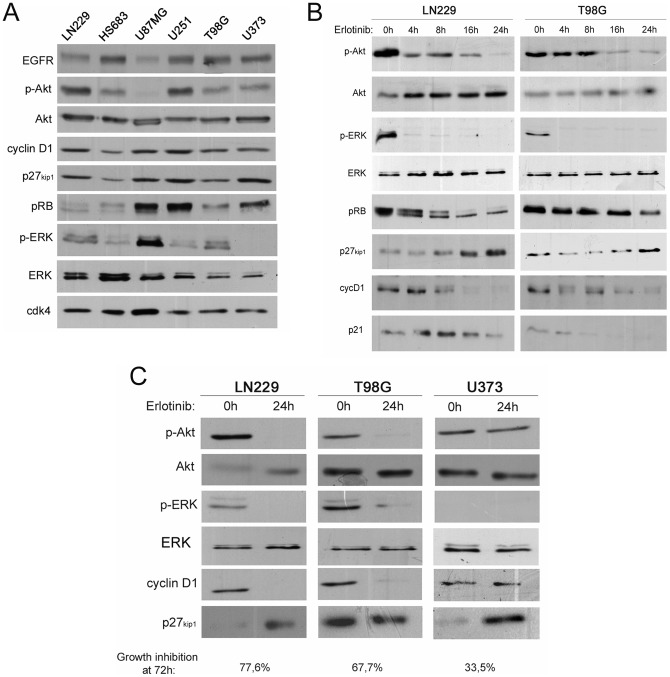
EGFR inhibition alters the expression levels of key cell cycle regulators.(A) The indicated human glioma cell lines were harvested and the expression levels of the indicated proteins were analyzed by western blotting with specific antibodies. (B) LN229 and T98G cells were treated with 10 µM erlotinib for the indicated time, harvested and the expression levels of the indicated proteins were analyzed by western blotting with specific antibodies. (C) As in B, but LN229, T98G and U373 cells were treated as indicated.